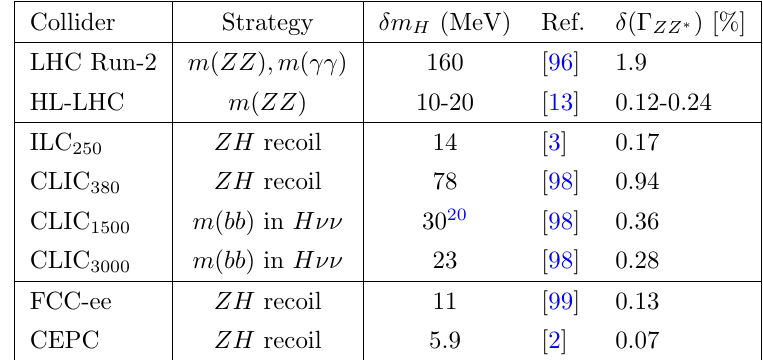
Table 16 . Overview of expected precision of Higgs boson mass measurements for future accelerators scenarios. For the lepton colliders (ILC, CLIC, CEPC) the projected uncertainties listed are statisti- cal only. The impact of (cid:14)m H on (cid:14) (cid:0) ZZ (cid:3) reported in this table is calculated as 1 : 2% (cid:1) ( (cid:14)m H = 100 MeV), following ref.